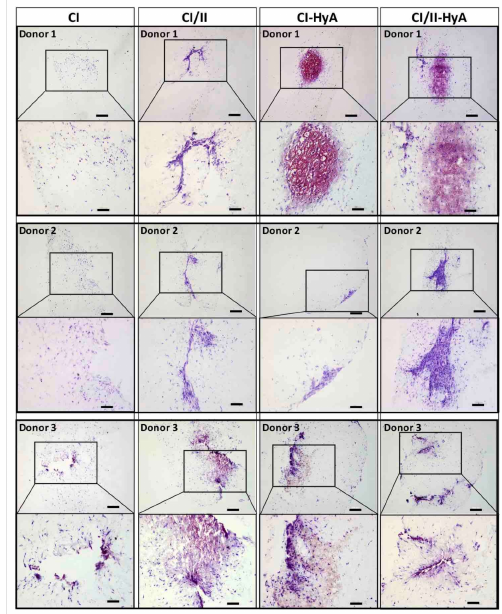
Figure 5. The incorporation of CII in combination with HyA improved sGAG distribution. Repre- sentative histological images of cell-seeded scaffolds stained with thionine after 28 days in culture. Scale bar represents 200 µ m length ( top images) and 100 µ m length ( bottom images). The histological images were collected for scaffolds seeded with human MSCs from donors 1, 2 and